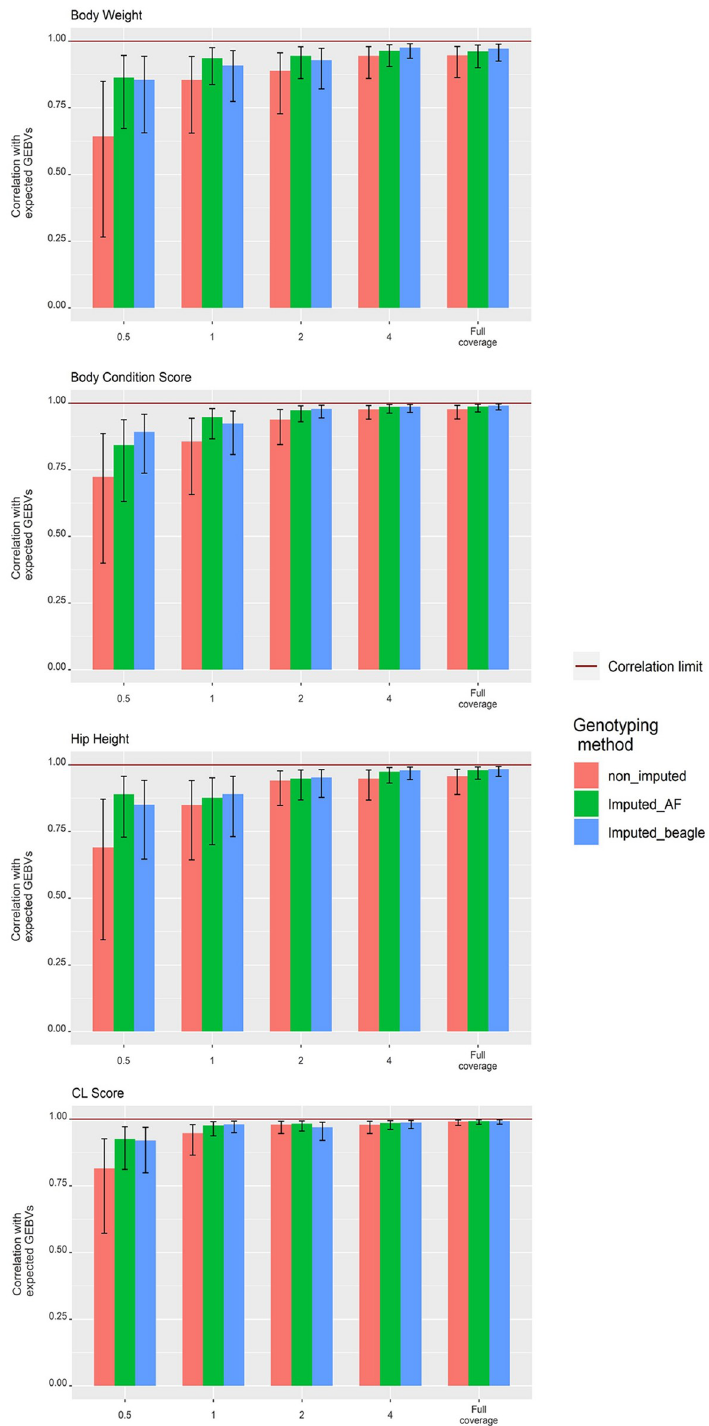
Fig 3. Correlations between the ONT genomic predictions and the expected GEBVs based on SNP array genomic predictions at five sequencing coverages for the four traits: A) body weight, B) hip height, C) body condition score, and D) CL